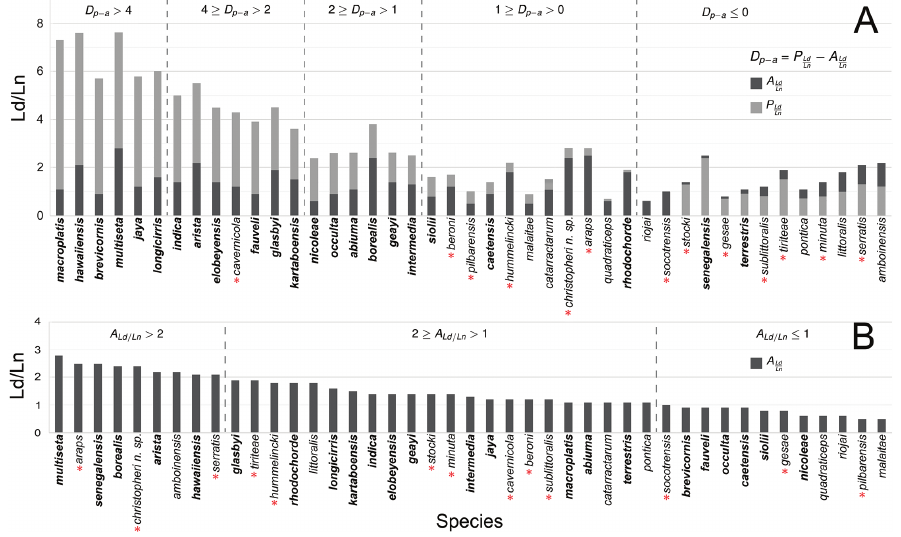
Figure 3. Histograms showing length ratios of parapodial cirri among Namalycastis (boldface) and Na- manereis (lightface) species. A Ratios between length of dorsal cirri (Ld) and length of neuroacicular lobe (Ln) at anterior (A ) and posterior chaetigers (P ), and difference among them (D ) B Ratios be- Ld/Ln Ld/Ln p−a tween length of dorsal cirri (Ld) and length of neuroacicular lobe (Ln) at anterior chaetigers (A ) only. Ld/Ln Sorted from highest to lowest ratios; asterisks highlight stygobiont Namanereis .